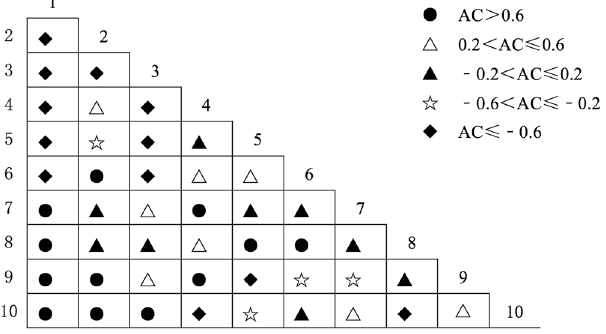
Figure 5. Half-matrix-diagram (AC Value) of interspecific association in Community III. Note: 1: Quercus wutaishansea, 2: Pinus tabulaeformis, 3: Populus davidiana, 4: Acer mono, 5: Swida macrophylla, 6: Pyrus betulaefolia, 7: Betula platyphylla, 8: Carya cathayensis, 9: Carpinus turczaninowii Hance, 10: Mountain peach